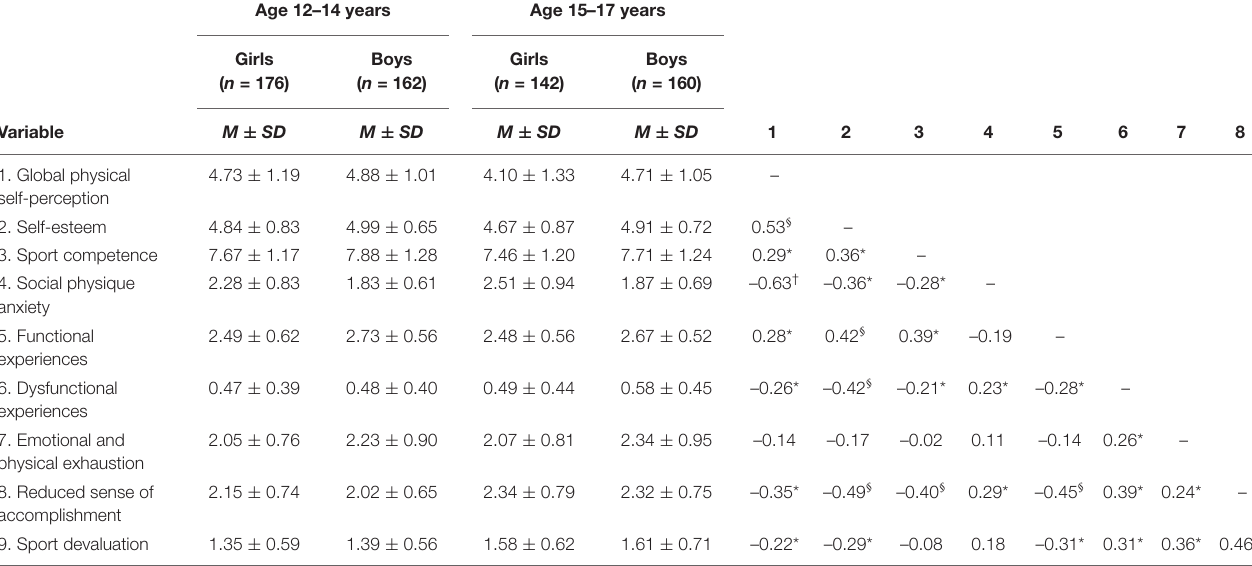
TABLE 1 | Descriptive statistics and Pearson product-moment correlation coefficients for the whole sample (N =